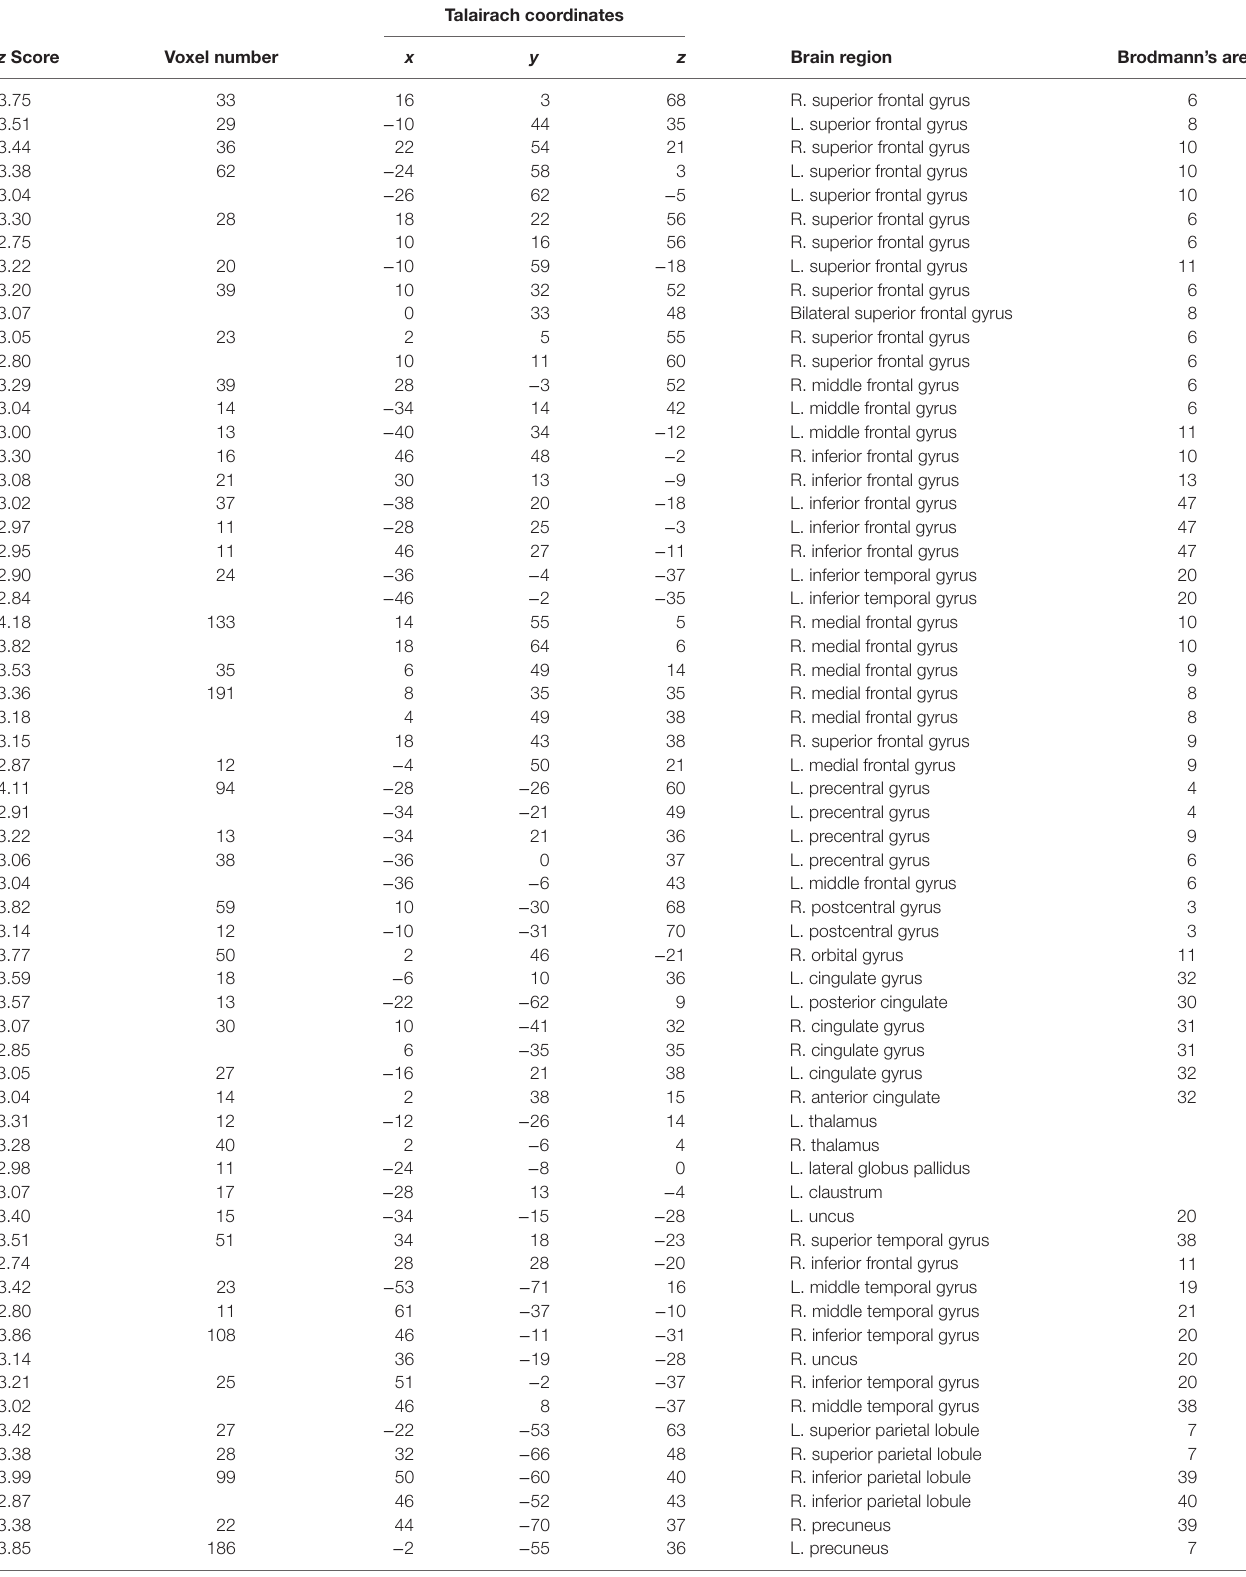
TaBle 5 | Areas of increased activation for traumatic slides and sounds after mindfulness-based stress reduction